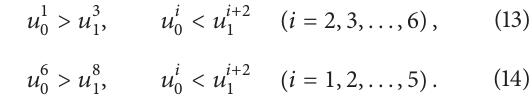
> 𝑢 2 ,𝑢 2 > 𝑢 3 , 𝑢 3 < 𝑢 4 } 0 1 0 1 0 1